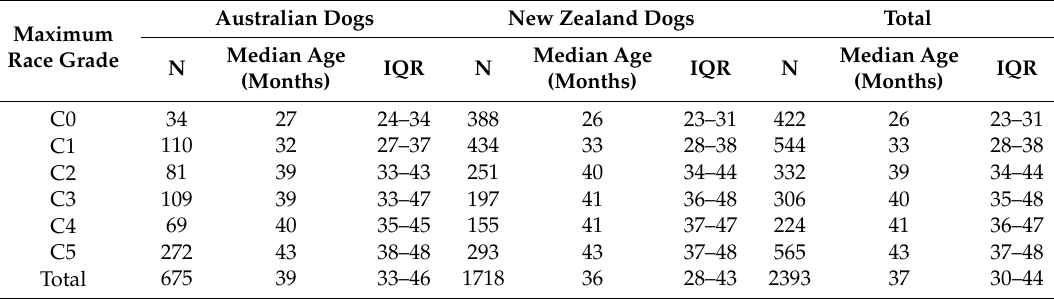
that raced in New Zealand during the 2013–2016 racing seasons.